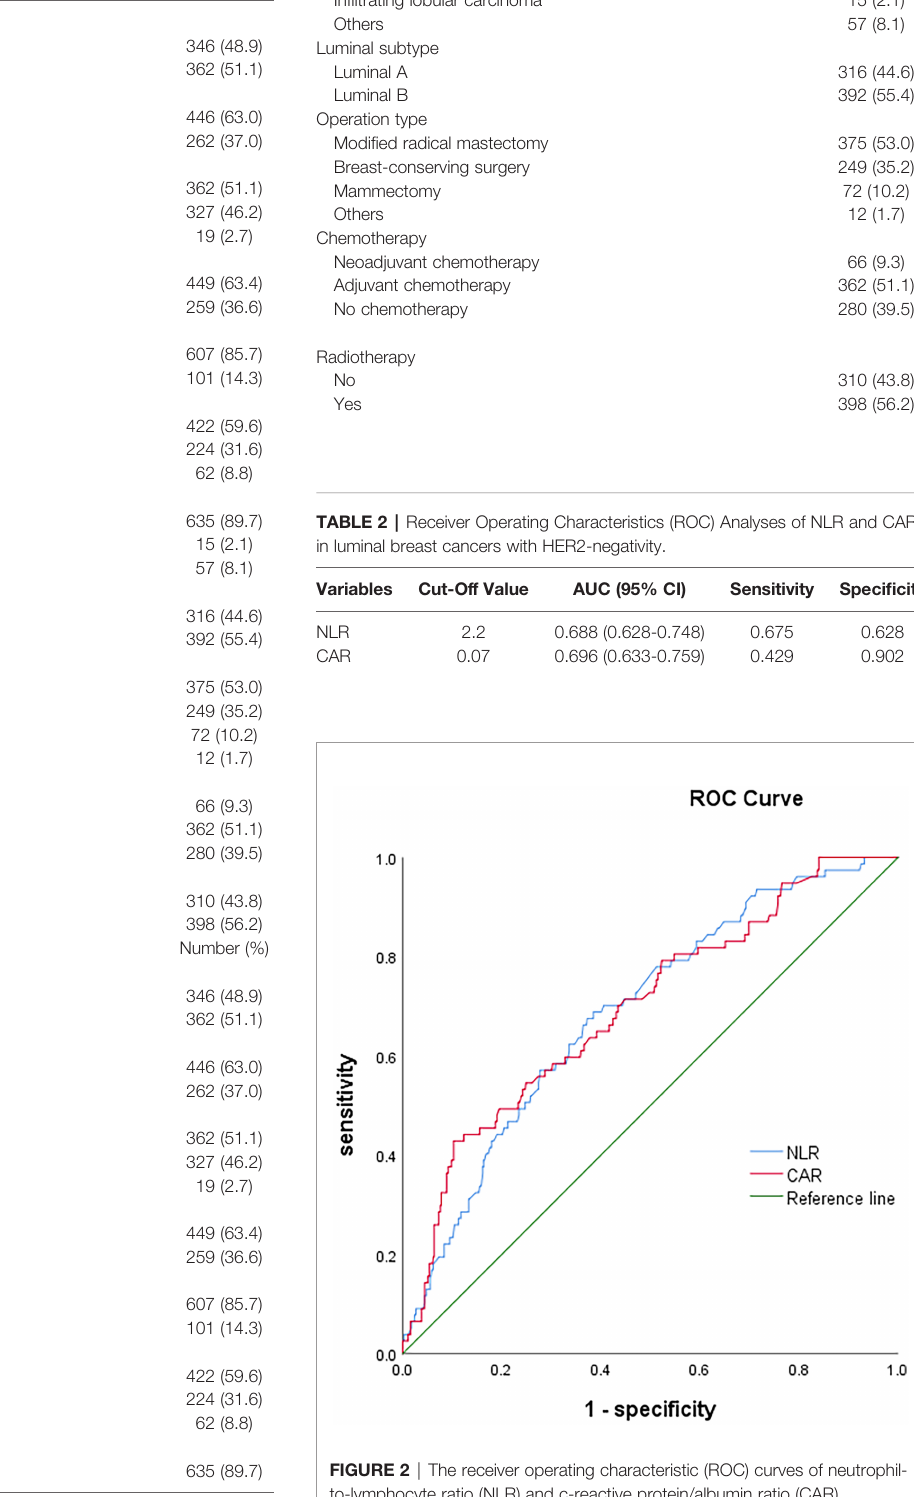
TABLE 1 | Clinicopathologic Characteristics of 708 luminal breast cancers with HER2-negativity. Characteristics